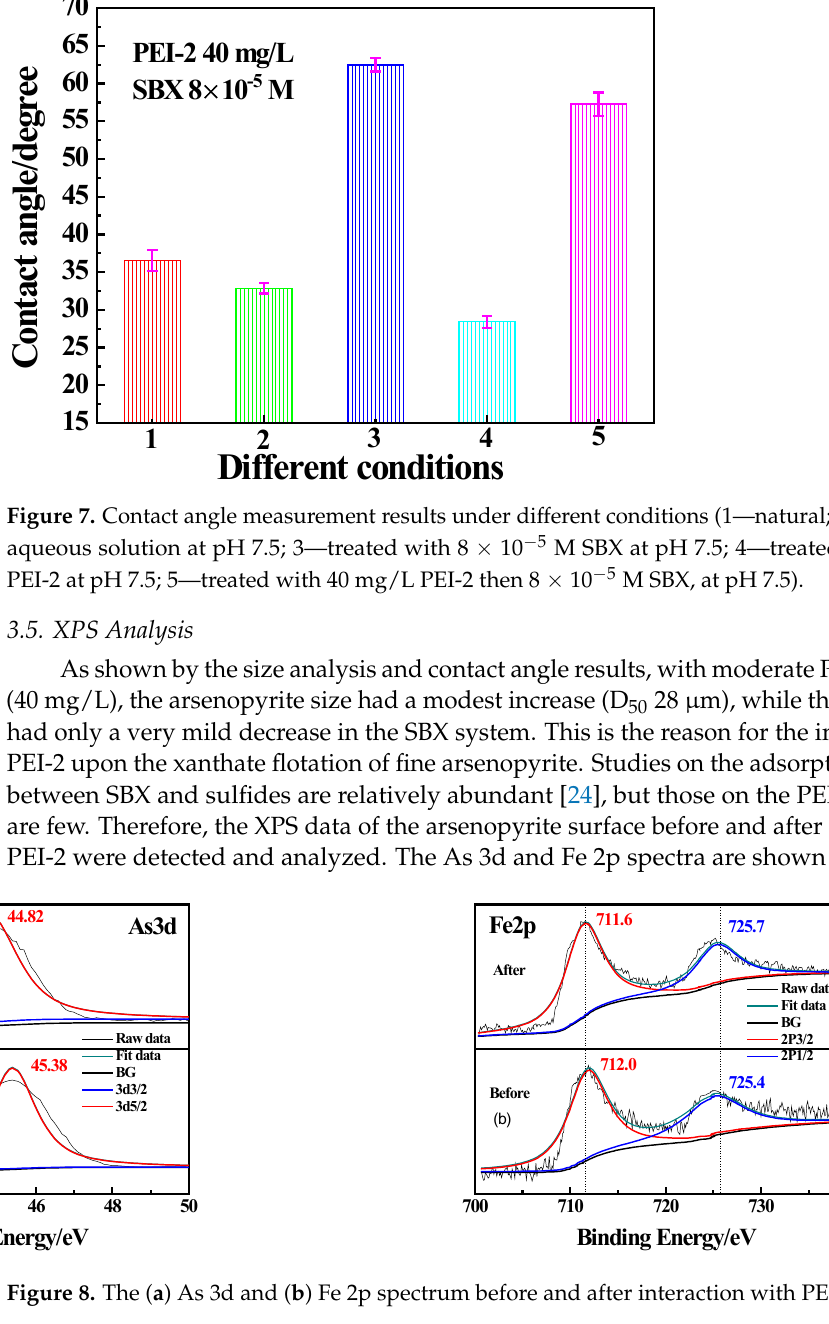
Figure 8. The ( a ) As 3d and ( b ) Fe 2p spectrum before and after interaction with PEI-2.